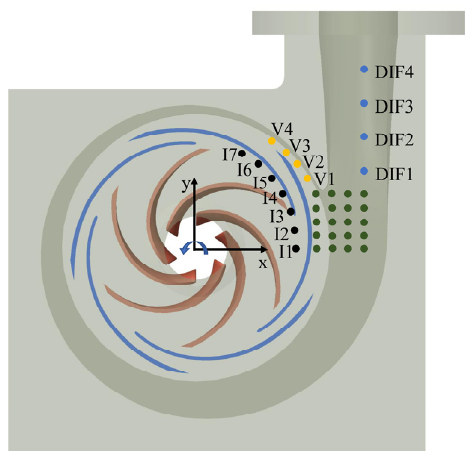
Figure 4. Measuring points for LDA in different regions within the model pump.